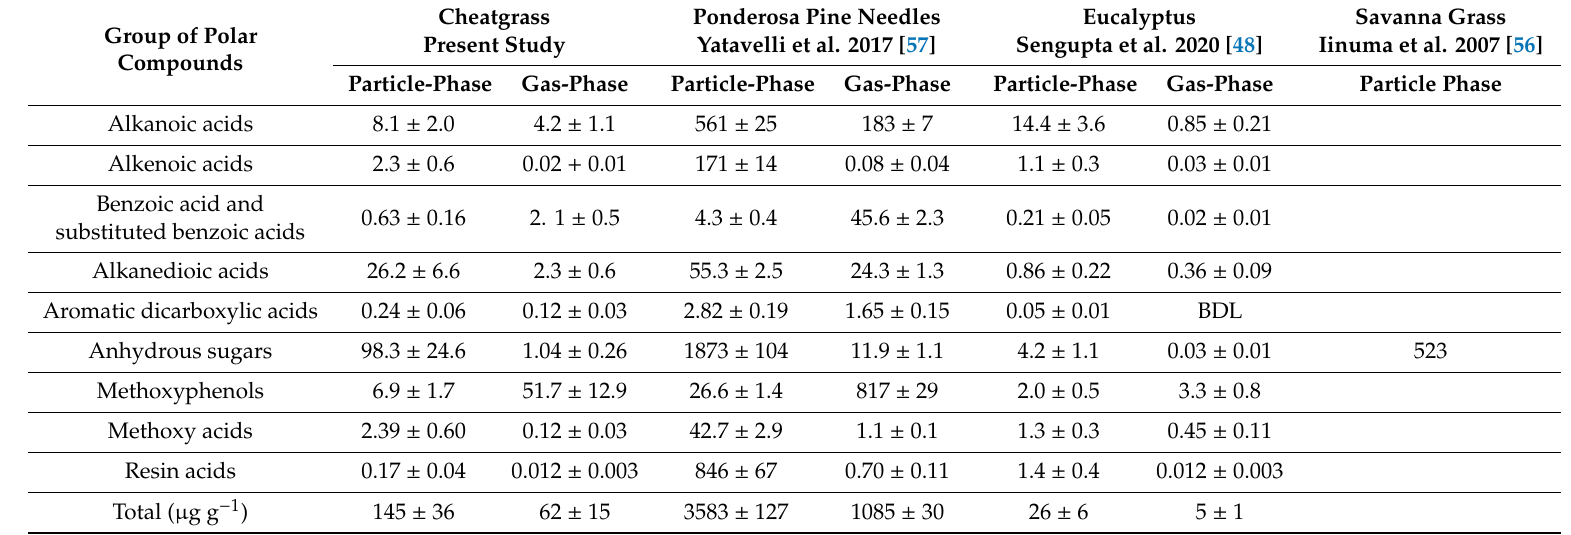
Table 4. EFs for gas- and particle-phase organic compounds in combustion emissions from cheatgrass, ponderosa pine needles, and savanna grass (units: µ g g − 1 of consumed fuel); BDL—below detection limit; the standard deviations represent analytical